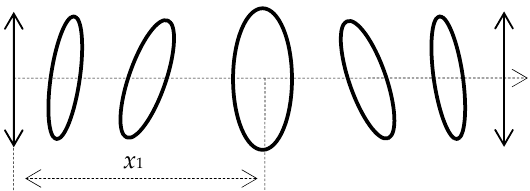
Figure 4. Continuous emission mode: the trajectory of particle motion in the summarized linear polarized transverse wave.